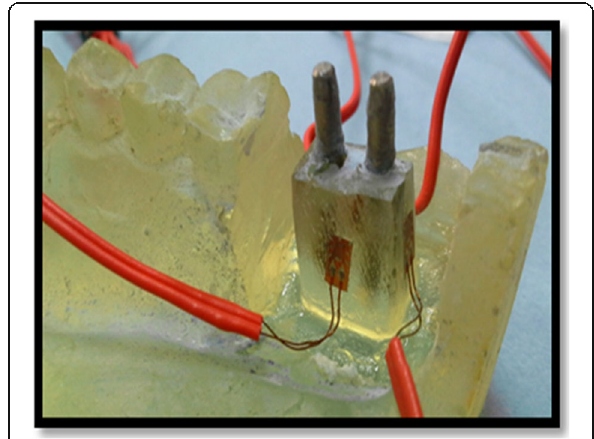
Fig. 4 Installation of strain gauges on surfaces of epoxy resin adjacent to mini implants